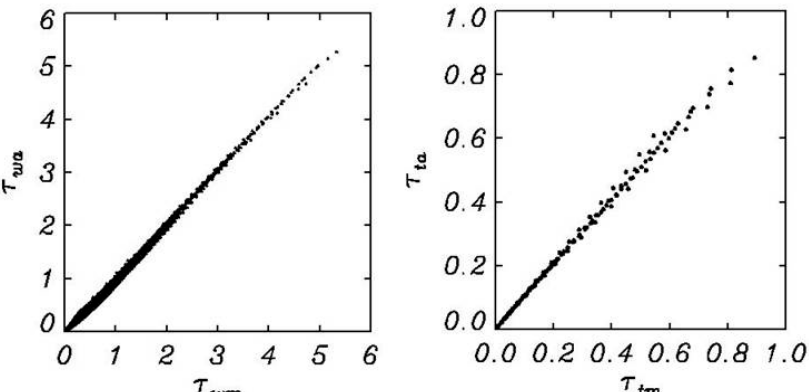
Figure 14. Comparison of the subgrid stresses calculated by model and by Equations (59)–(62) (m 2 / s 2 ) . Left panel : comparison of the wave-produced surface stress obtained with a high-resolution wave model τ wm with approximations τ wa by Equations (59) and (60). Right panel : the same as in the left panel, but for the tangent stress τ tm and approximations τ ta by Equations (61) and (62).